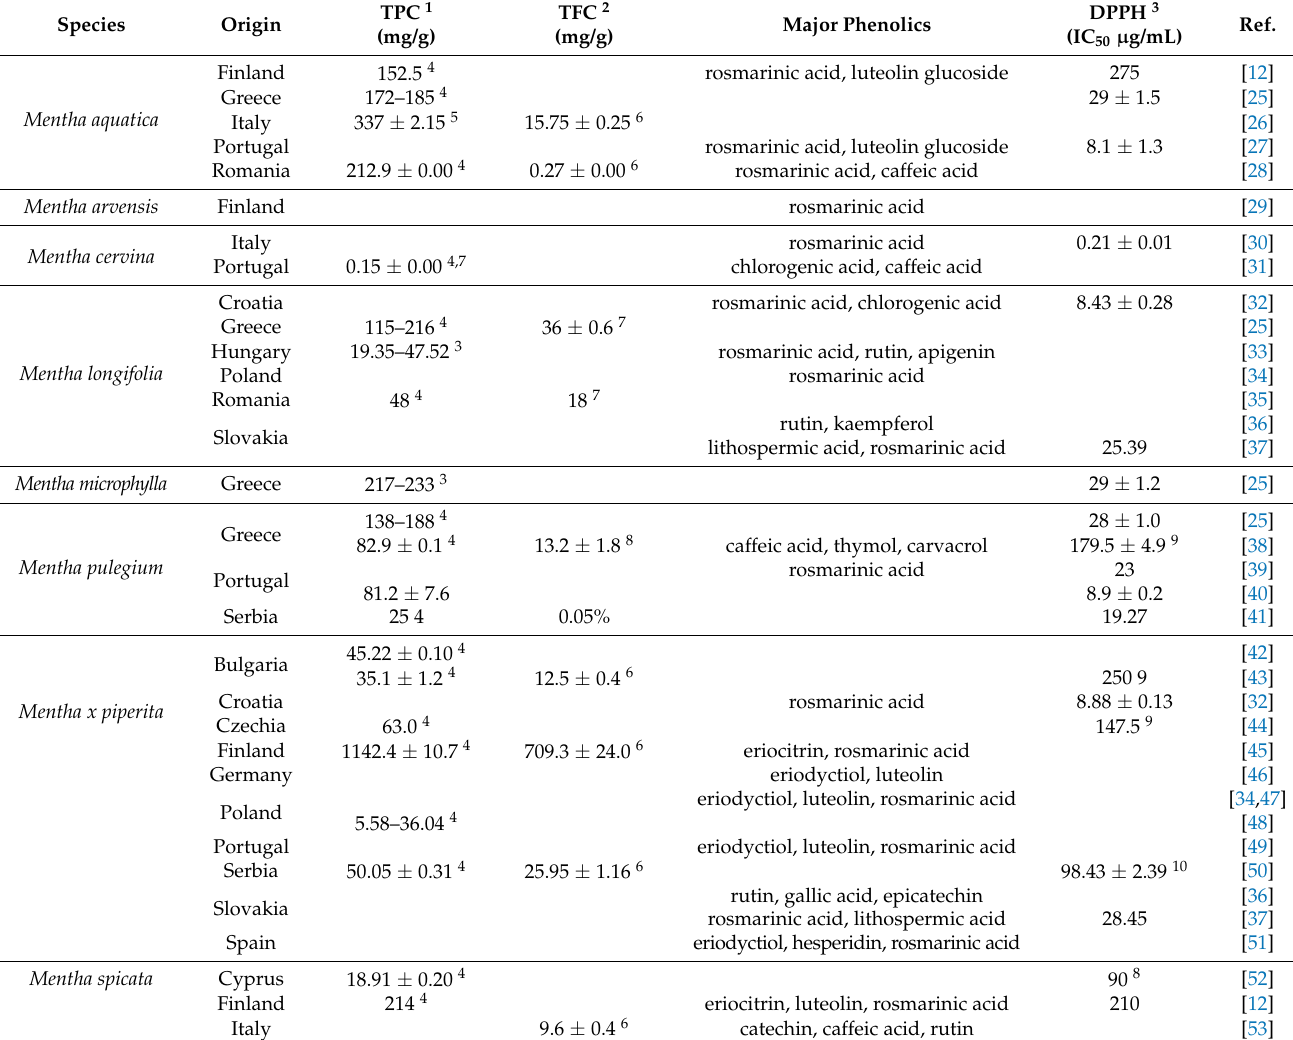
Table 1. Literature overview on phenolic compounds in selected Mentha sp . of European